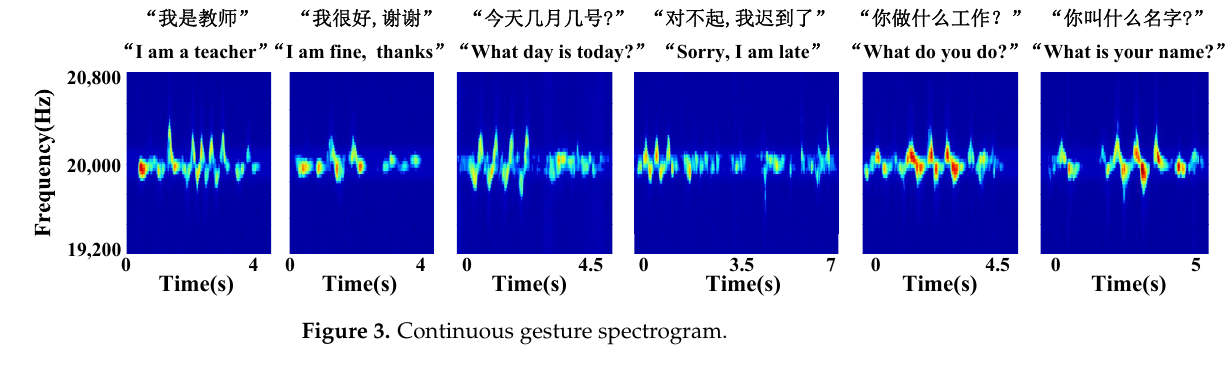
Figure 3. Continuous gesture spectrogram.